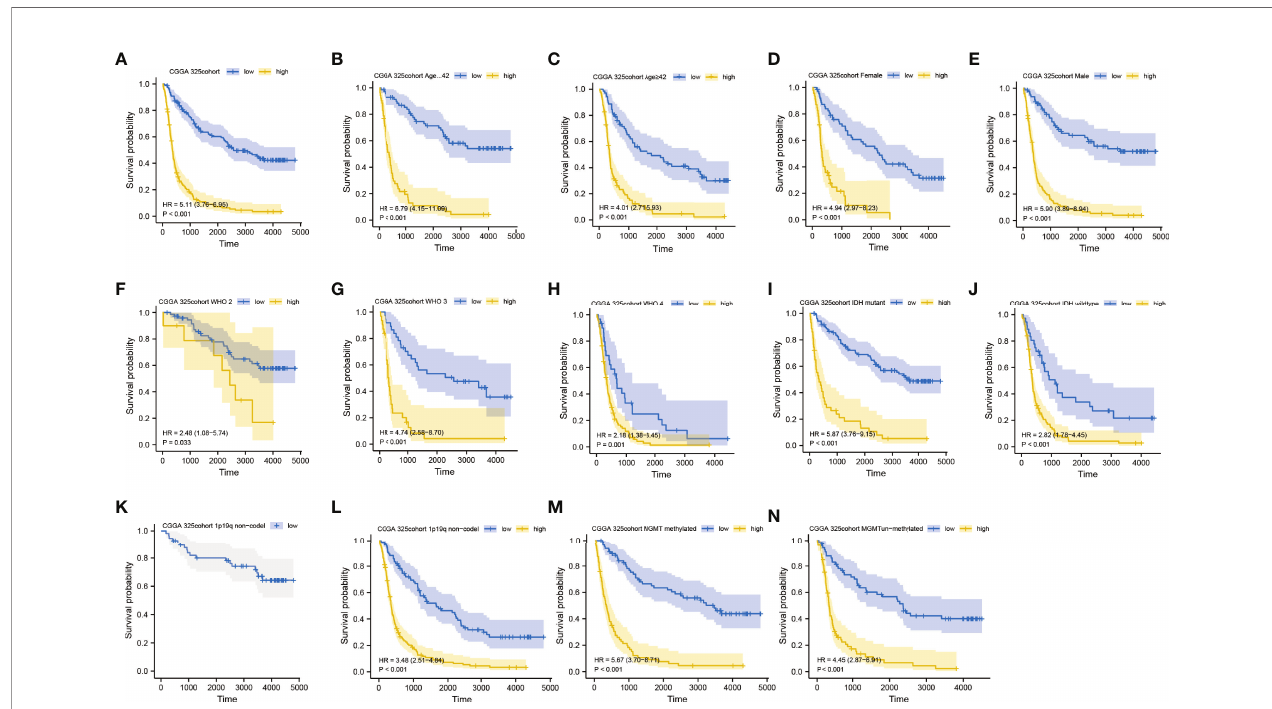
FIGURE 4 | Predictionofoutcome oftheDDOST instrati fi edpatientsintheCGGA325 dataset.SurvivalcurvewasusedtoanalyzeOSinthelow-andhigh-DDOSTgroupsin CGGA325 set (A) .Survivalanalysisofthesignatureinpatients strati fi edbyage (B, C) , gender (D,E) ,grade (F,H) ,IDH (I,J) ,1p19qstatus (K, L) ,andMGMTpromoter (M,N) .